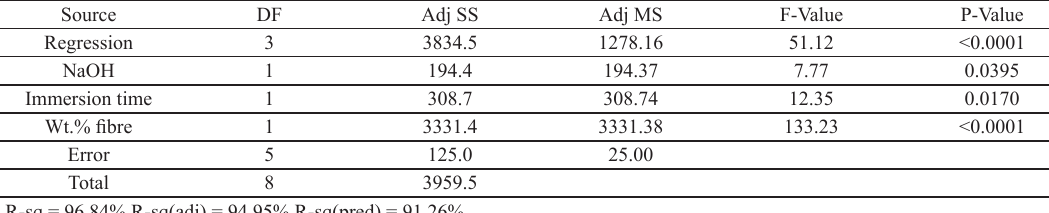
Figure 7. Main effect plots for the mean tensile strength Table 4. Analysis of Variance (ANOVA) of tensile strength.